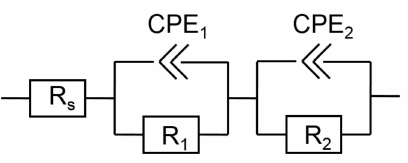
Figure 5. Equivalent electrical circuit of the studied DSSCs. R—resistor, CPE—constant phase